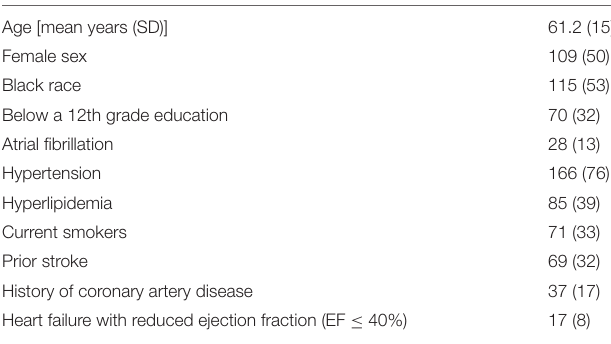
TABLE 1 | Characteristics of the cohort ( N = 218)*.